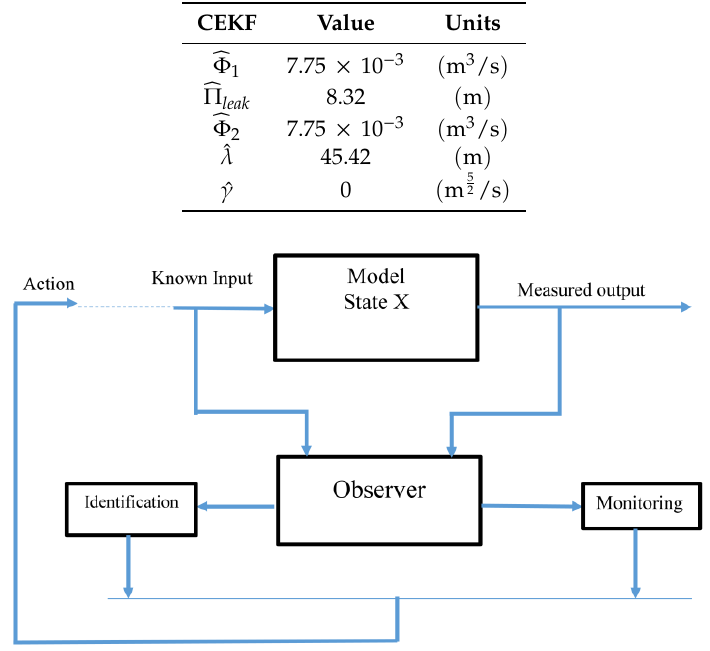
Table 1. Initialization second order extended Kalman filter (SEKF).